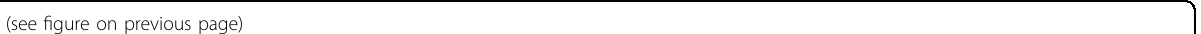
Fig. 4 Evogliptin inhibited the VEGF-induced formation of focal adhesions and phosphorylation of FAK and caveolin-1 in endothelial cells. a Immunocytochemical detection of paxillin (green)-positive focal adhesions (white arrows) in HUVECs treated with or without evogliptin (Evo) and VEGF. b , c Representative western blotting images and densitometric analysis of phosphorylated b FAK (p-FAK) and c caveolin-1 (p-Cav1) in HUVECs treated with or without Evo and VEGF. Cell lysates were subjected to western blot analysis, and the signal intensity of the protein bands was determined by densitometry (three independent experiments). Band intensities of phosphorylated proteins were normalized to those of the total proteins. d Immunocytochemical detection of the colocalization of p-VEGFR2 and p-FAK and that of p-FAK and p-Cav1 in HUVECs treated with or without Evo and VEGF. The arrowheads indicate the spatial overlap between p-VEGFR2 (red) and p-FAK (green) and between p-FAK (green) and p- Cav1 (red). e Representative western blotting images and densitometric analysis of p-FAK and p-Cav1 in the retinal tissues of normal mice and mice with OIR. On P12, mice with OIR received a single intravitreal injection of Evo or DMSO (Cont). On P13, the retinal tissues of normal mice and mice with OIR were harvested for western blotting ( n = 3 mice). All data are presented as the mean ± SEM (one-way ANOVA with Bonferroni post hoc multiple comparison test, * p < 0.05, ** p < 0.01, *** p < 0.001). In a and d , the nuclei were stained with 4 ʹ ,6-diamidino-2-phenylindole (blue), and nonspeci fi c IgGs were used as a negative control (NC). Representative immunocytochemical images were selected from three independent experiments with similar results. Scale bars = 25 μ